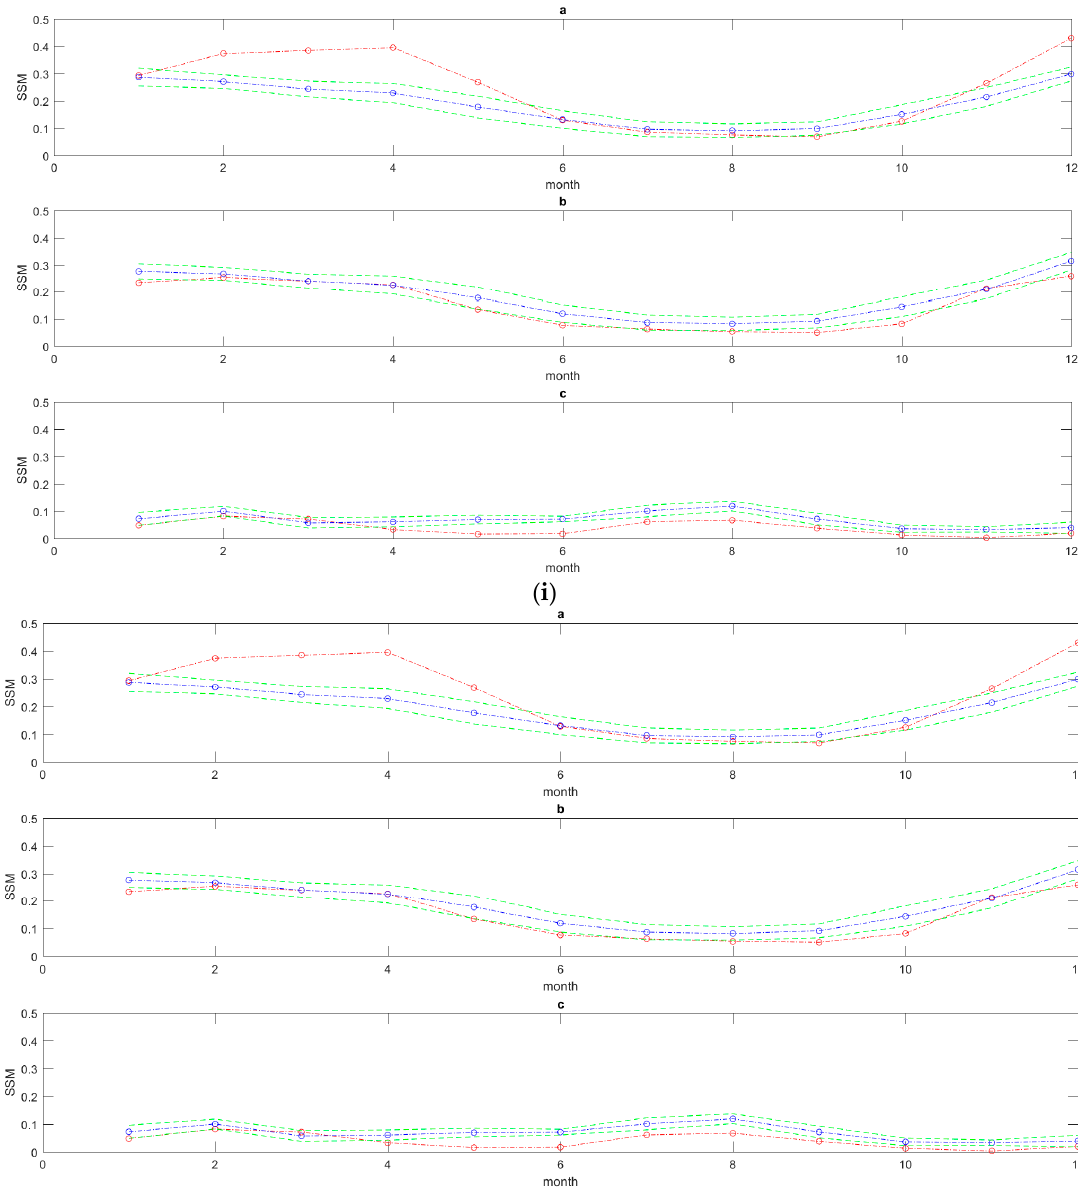
Figure 7. Temporal dependence of monthly averages of in situ and predicted SSM from ASCAT 25Km for the different land cover types of USA throughout ( i ) 2010 and ( ii ) 2011. Results are shown for: ( a ) US_TON, ( b ) US_VAR, and ( c ) US_WHS. Blue is the ASCAT SSM and red is the in situ SSM. The green dashed lines represent the 95% confidence